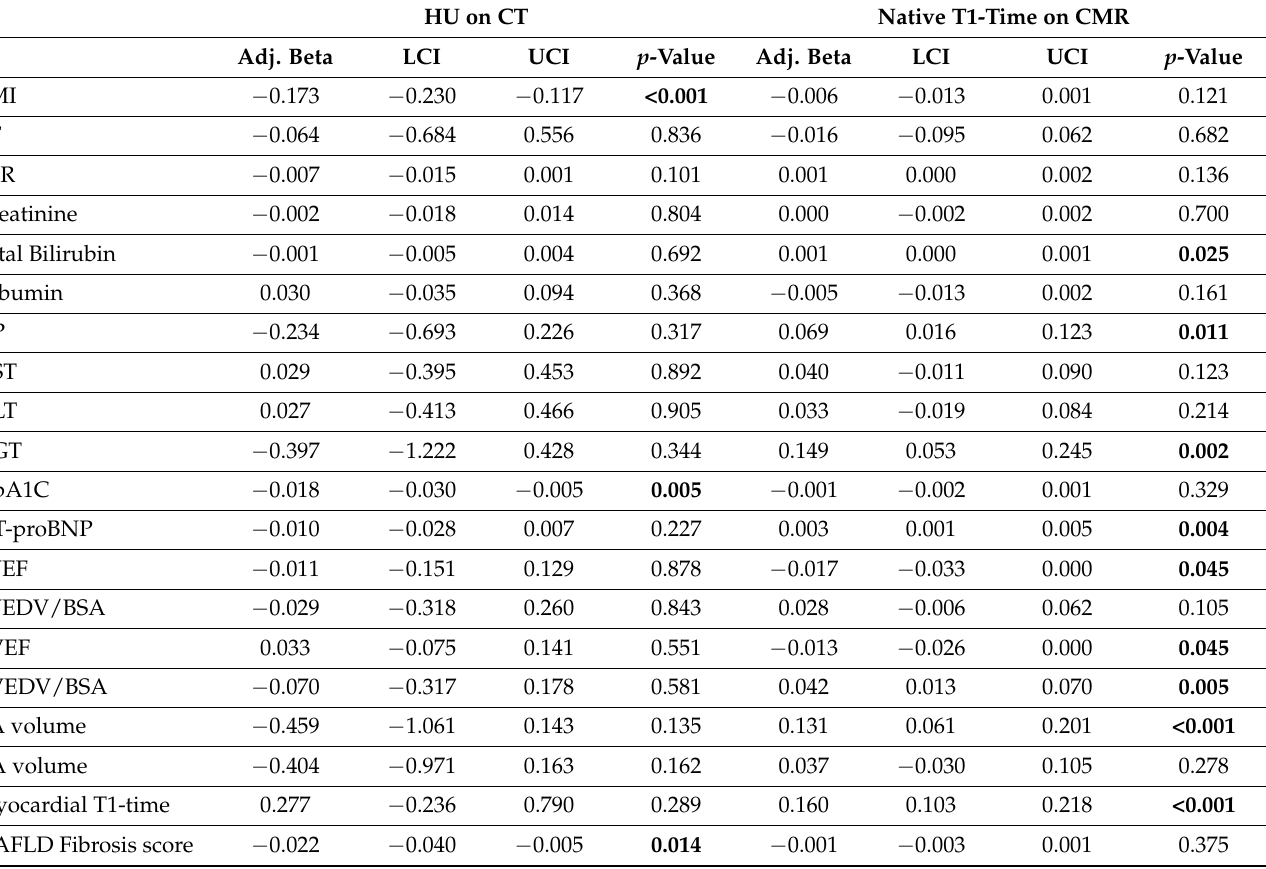
Table 2. Linear regression models, adjusted for age and sex, demonstrating the association of liver HU values on non-contrast computed tomography and native liver T1-times on cardiovascular magnetic resonance imaging with baseline variables. HU on CT Native T1-Time on